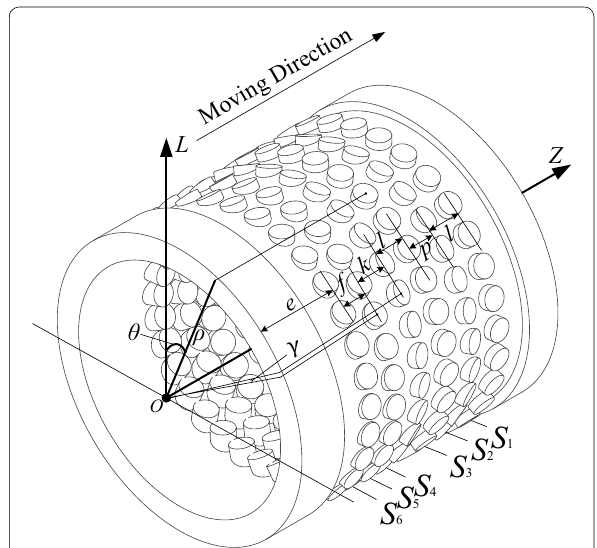
Figure 1 Diagram of geometric structure of composite transducer